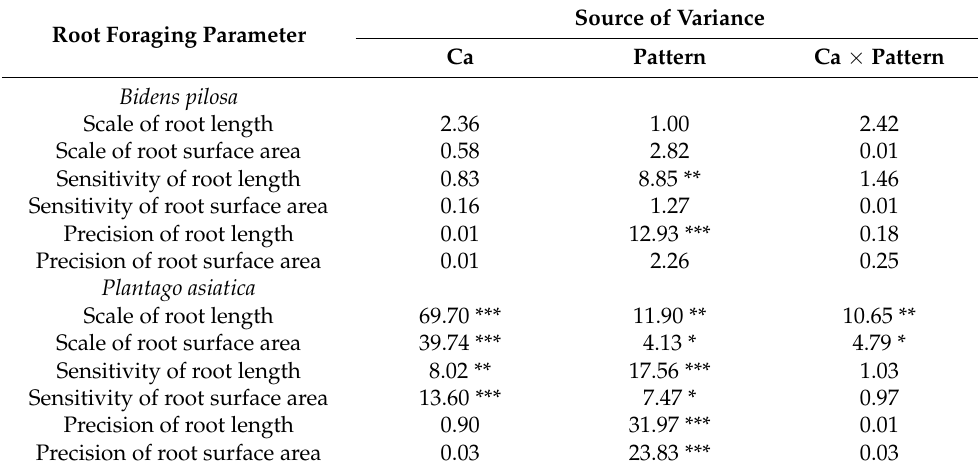
Table 2. Analysis of variance (ANOVA) of Ca concentration, P placement pattern, and their interaction (Ca × Pattern) on root foraging sensitivity, precision, and scale of individuals in Bidens pilosa L. and Plantago asiatica L.